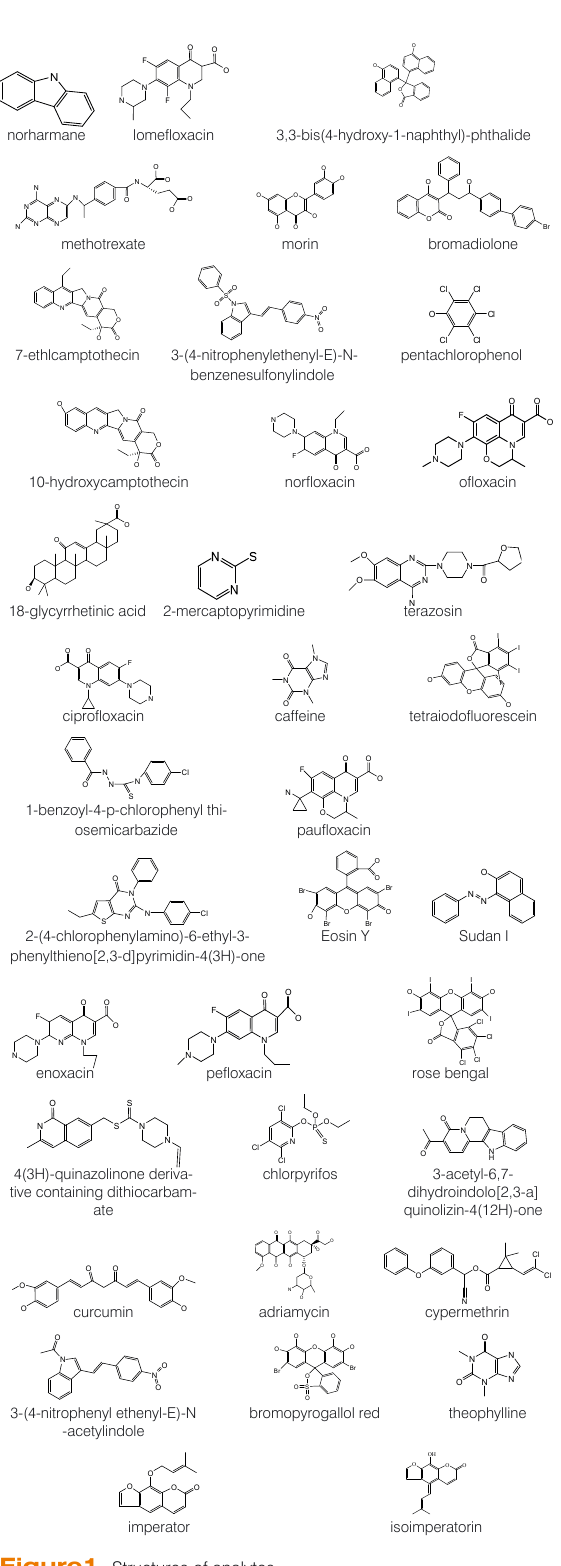
Figure1. Structures of